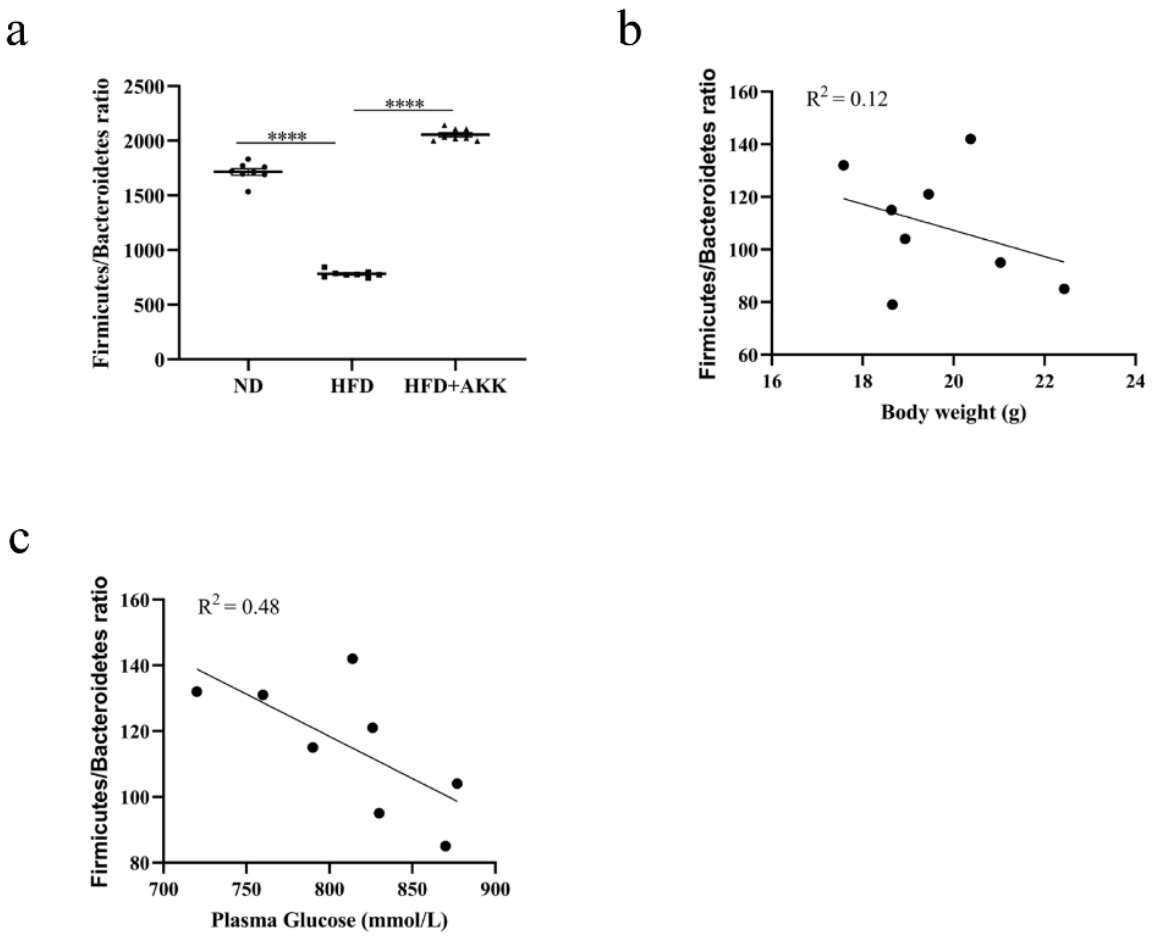
Figure 5. Correlation analysis of gut microbiota and obesity phenotype in HFD-induced beagles. ( a ) The Firmicutes/Bacteroidetes ratio in different groups. ( b ) Correlation between body weight and the Firmicutes/Bacteroidetes ratio (Correlation coefficient R 2 = 0.12). ( c ) Correlation between plasma glucose and the Firmicutes/Bacteroidetes ratio (Correlation coefficient R 2 = 0.48). Statistical analyses were performed with unpaired Student-t test. * p < 0.05, ** p < 0.01, *** p < 0.001 and **** p < 0.0001.